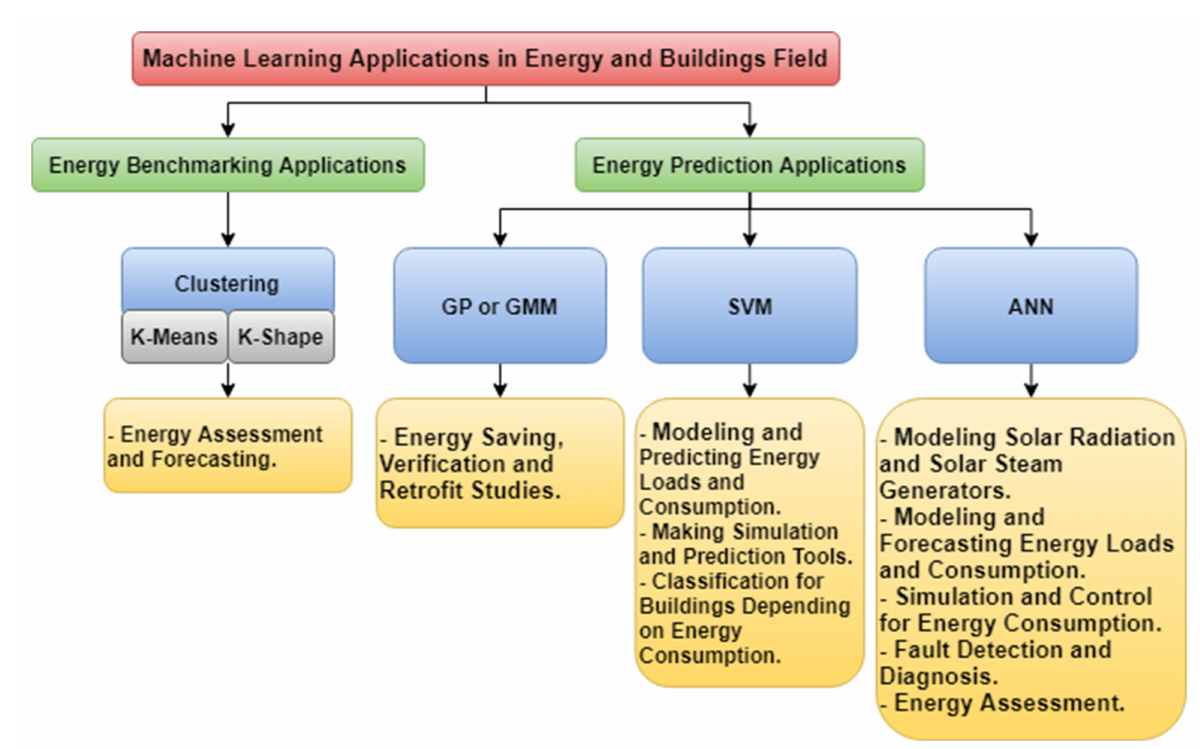
Figure 1. The popular applications for four types of ML algorithms around the world in the energy and buildings